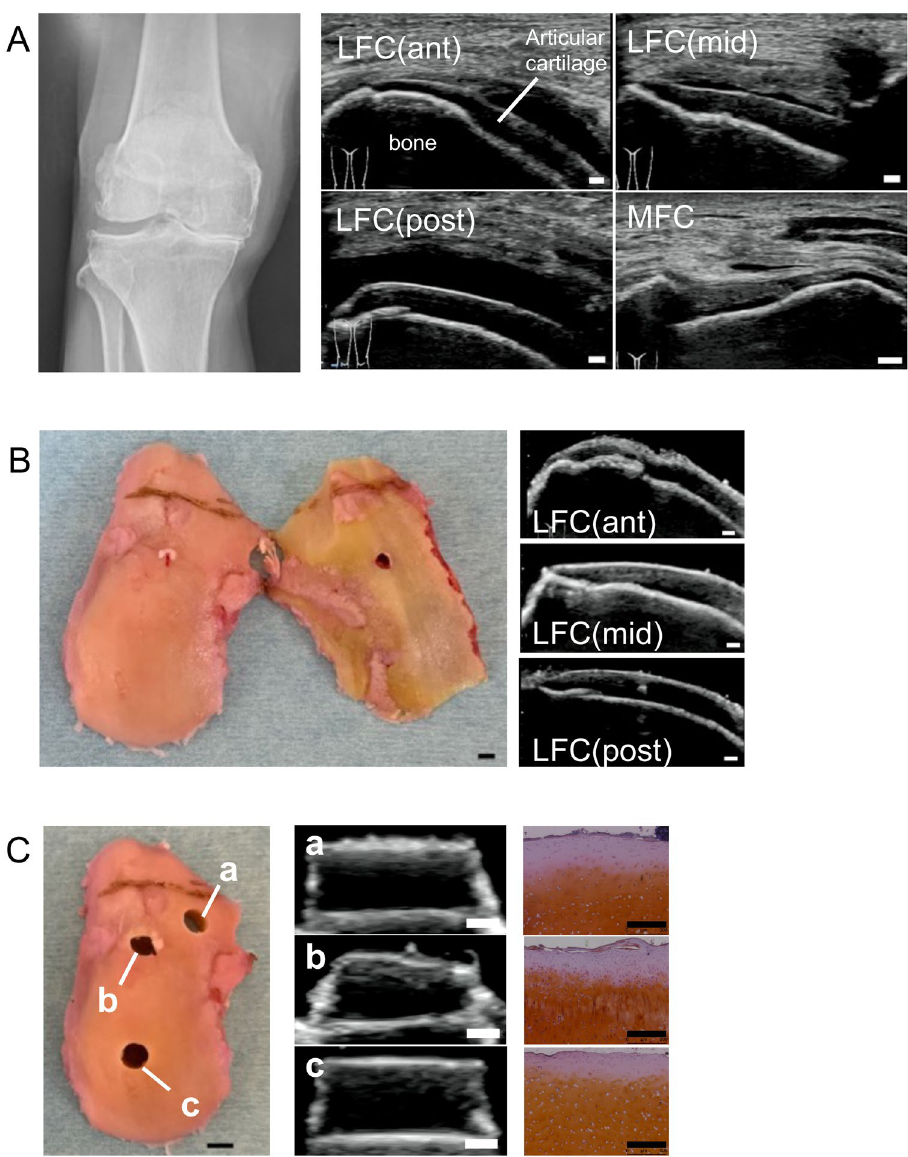
Figure 6. Ultrasound of knee joint articular cartilage reflects various degenerative lesions. ( A ) Plain radiograph and ultrasound images before surgery. The ultrasound images depicted the distal medial femoral condyle (MFC) and three different positions of the lateral femoral condyle (LFC). ant; anterior, mid; middle, post; posterior. ( B ) Ultrasound images of three different positions of the surgically resected specimen. ( C ) Osteochondral columns harvested from three different locations. Scale bars: 1 mm (US), 500 μm (SO), 5 mm